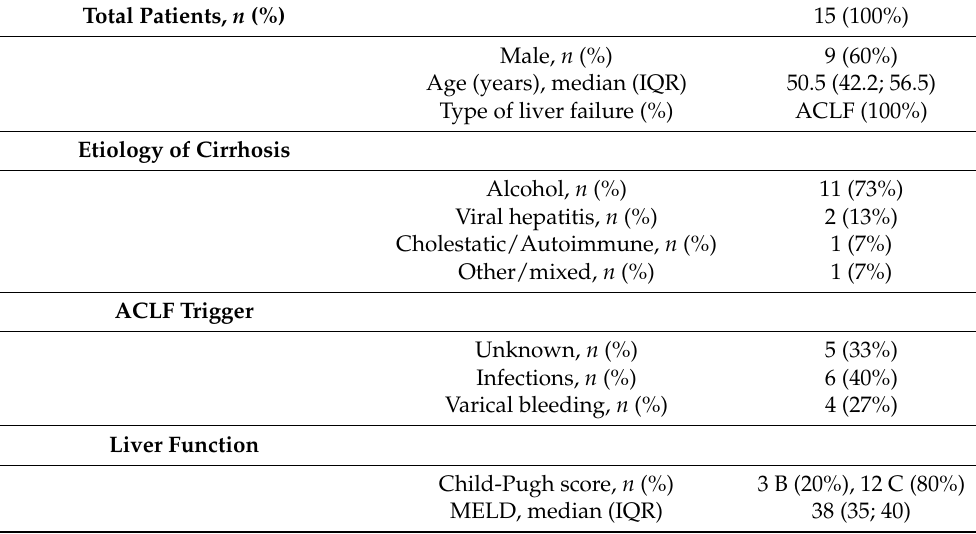
Table 2. Baseline characteristics of included